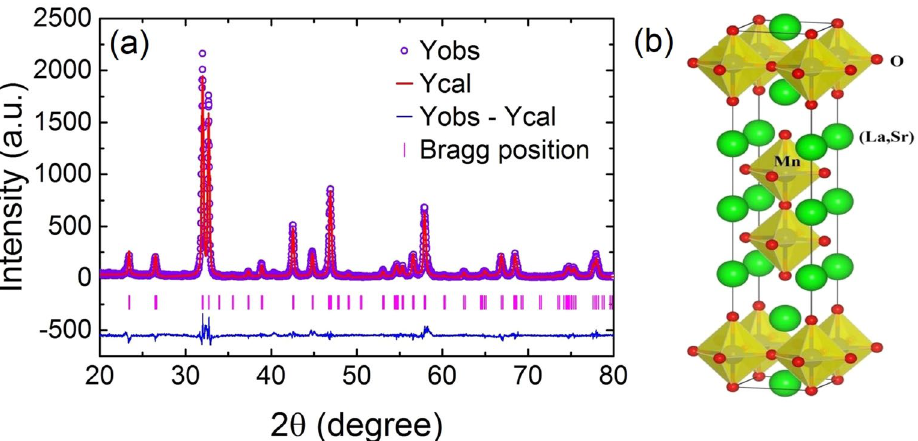
Figure 2. ( a ) Rietveld refinement of the room temperature XRD of La 1.4 Sr 1.6 Mn 2 O 7 . Navy blue circles: experimental data. Red line: calculated pattern. Pink ticks: positions of the Bragg reflections for the main phase. Blue line: difference between the experimental and calculated patterns, and ( b ) crystal structure of the bilayer La 1.4 Sr 1.6 Mn 2 O 7 . The MnO 6 octahedrons in the crystalline bulk are denoted in yellow color, whereas different colors of the spheres represent the different atoms (red—O, light green—(La, Sr) and blue—Mn). The bilayer repeat distance is ≈ 9.90 Å.